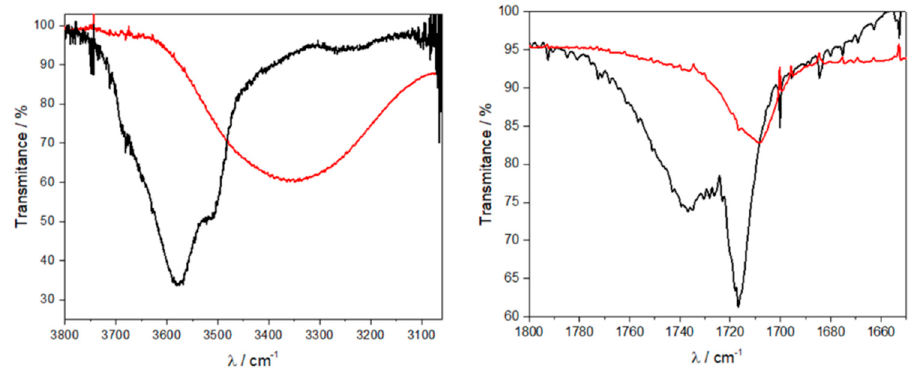
Figure 3. Fourier-transform infrared spectroscopy (FTIR) spectra of 1 in THF and in the solid state showing the O–H ( left ) and C=O ( right )